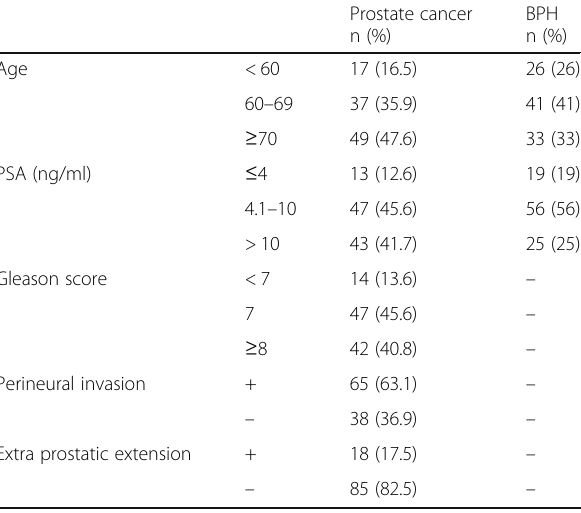
Table 4 The clinical and demographic information of the